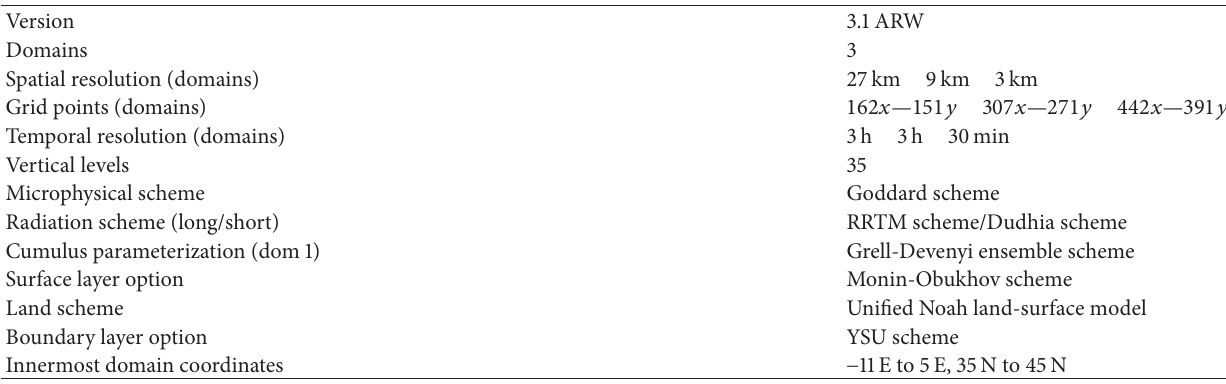
Table 1: NWP model description.